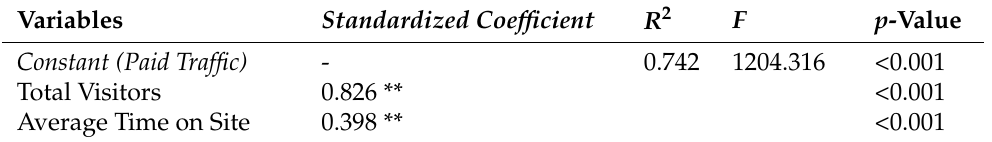
Table 10. Fourth hypothesis’